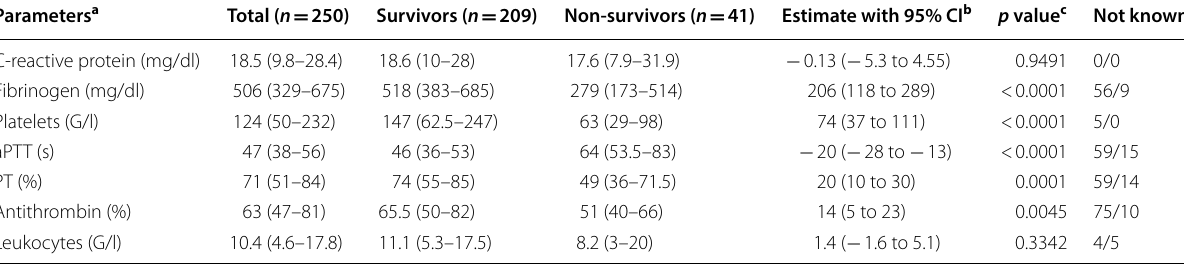
a Data are presented as medians (25th–75th percentile) b Estimated median difference c Differences between survivors and non-survivors assessed with Wilcoxon rank sum test for continuous variables d Number of missing measurements in